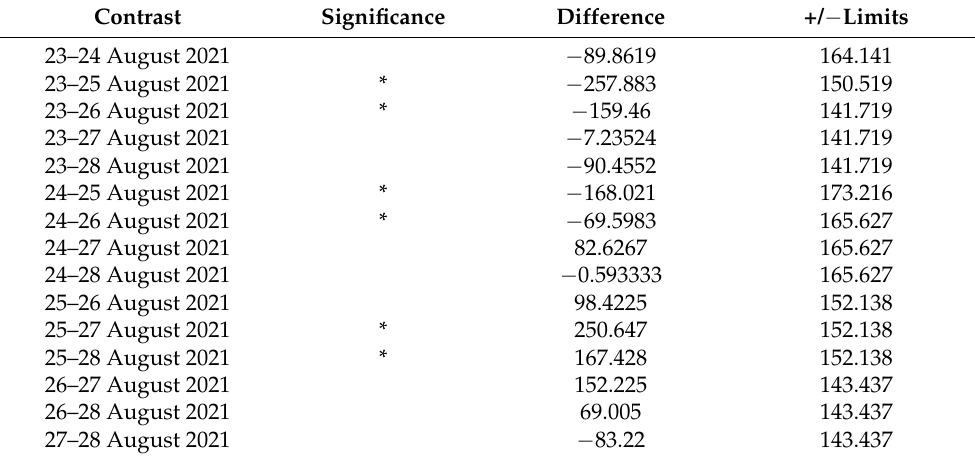
Table 1. Results of Duncan’s multiple range test for mean solar radiation during the monitoring days. Contrast Significance